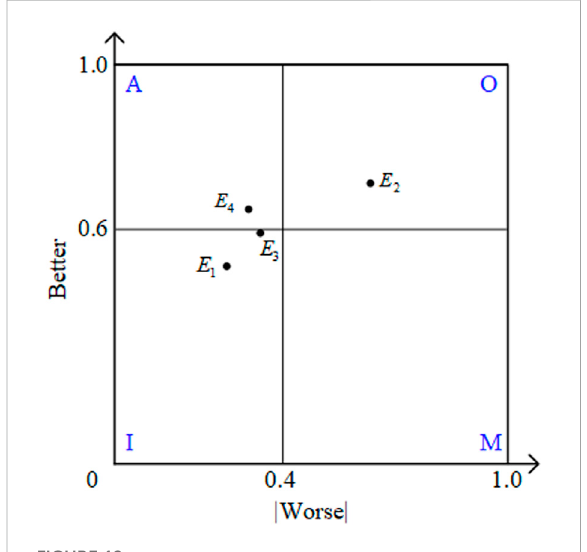
FIGURE 12 Better-Worse coef fi cient quadrant chart.